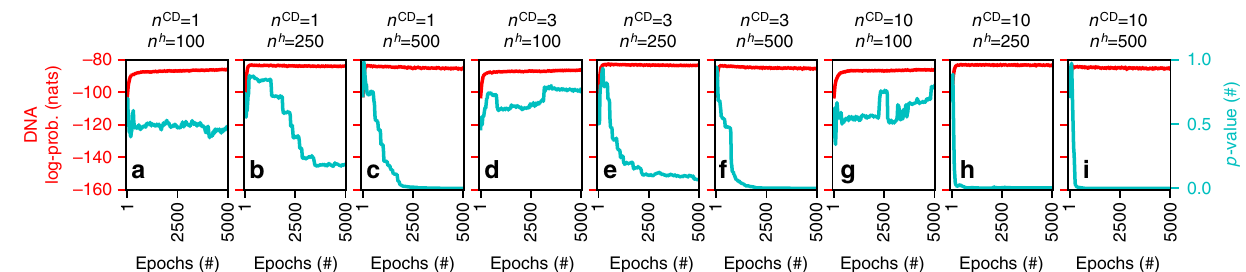
Fig. 3 SET-RBM evolution towards a scale-free topology on the DNA dataset. We have considered three cases for the number of contrastive divergence steps, n CD = 1 ( a – c ), n CD = 3 ( d – f ), and n CD = 10 ( g – i ). Also, we considered three cases for the number of hidden neurons, n h = 100 ( a , d , g ), n h = 250 ( b , e , h ), and n h = 500 ( c , f , i ). In each panel, the x axes show the training epochs; the left y axes (red color) show the average log-probabilities computed for SET-RBMs on the test data with AIS 33 ; and the right y axes (cyan color) show the p -values computed between the degree distribution of the hidden neurons in SET-RBM and a power-law distribution. We may observe that for models with a high enough number of hidden neurons, the SET-RBM topology always tends to